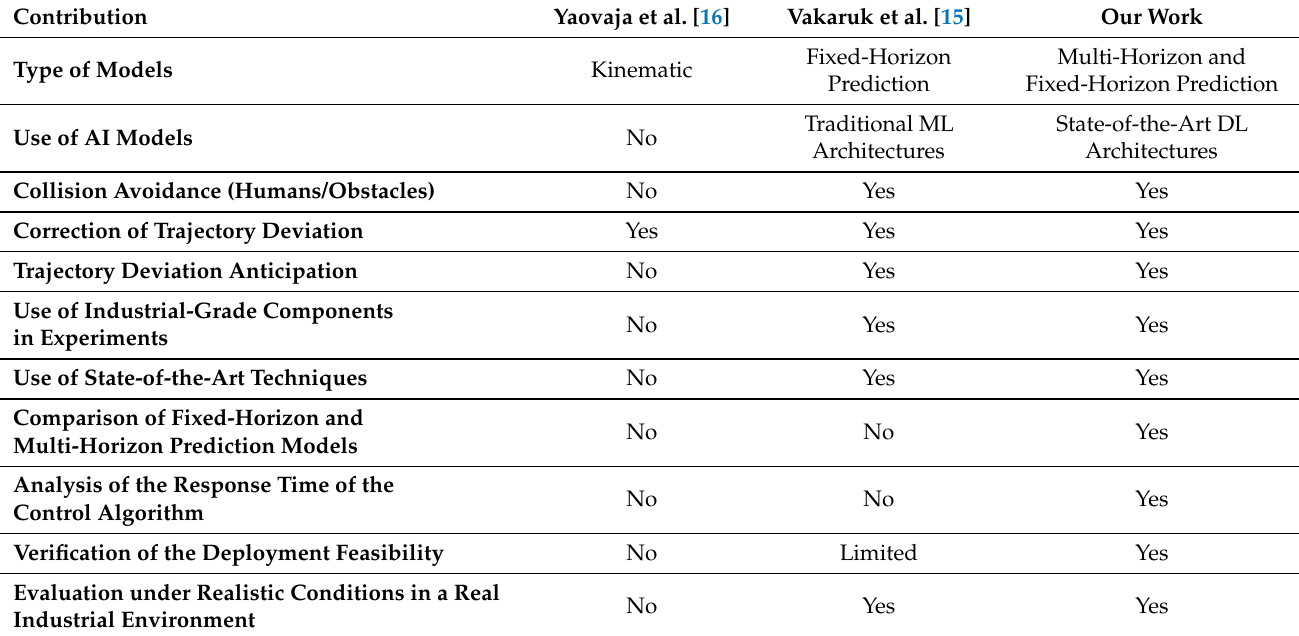
Table 1. Comprehensive analysis of studies related to the current research